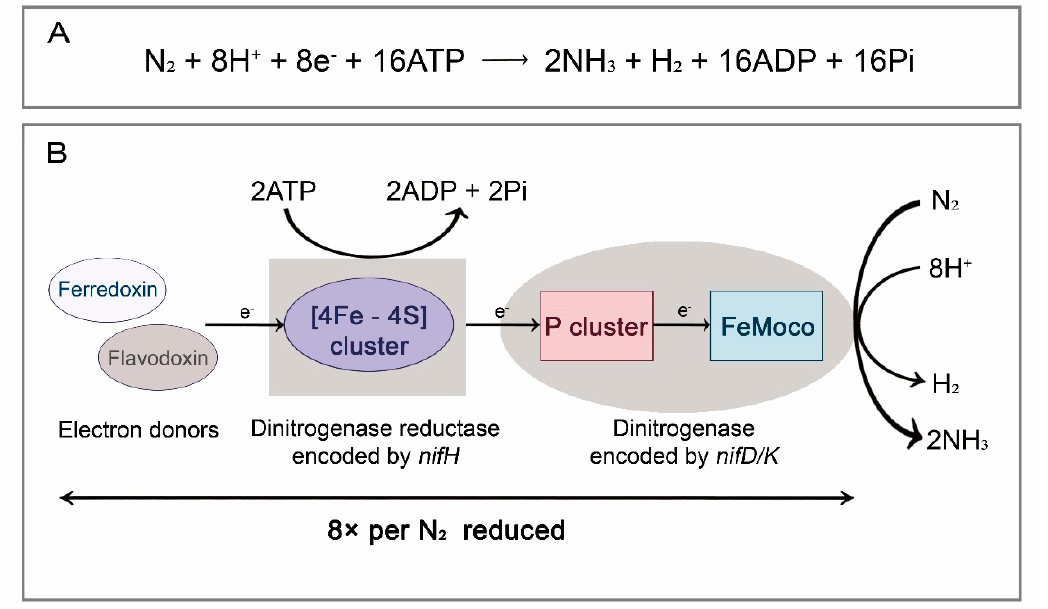
Figure 1. BNF reaction and its molecular mechanism. ( A ) Chemical reaction formula for BNF; ( B ) schematic diagram of dinitrogen reduction. Electrons are transferred from ferredoxin/flavodoxin via dinitrogenase reductase to dinitrogenase. At least 16 molecules of MgATP are consumed for each reduction of a dinitrogen.